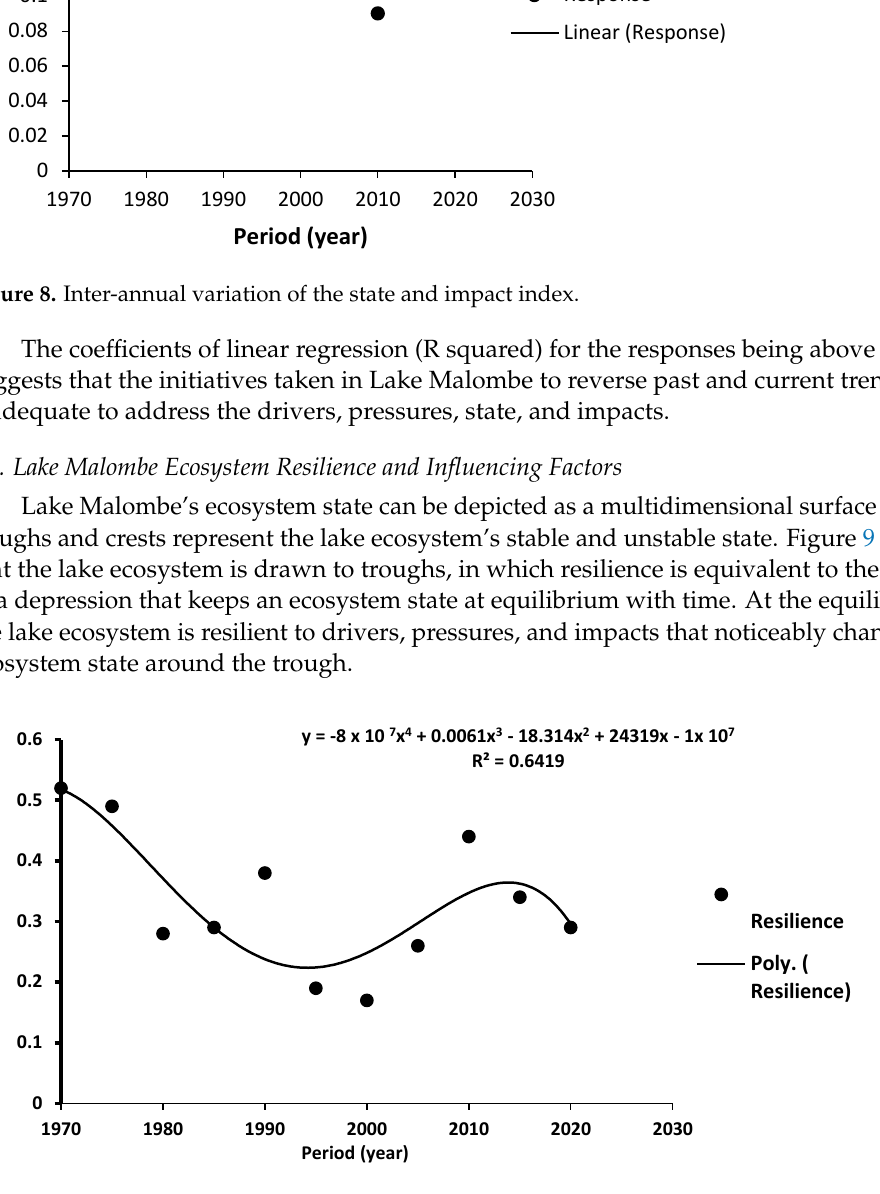
Figure 9- A cup diagram illustrating the Lake Malombe ecosystem ’s resilience